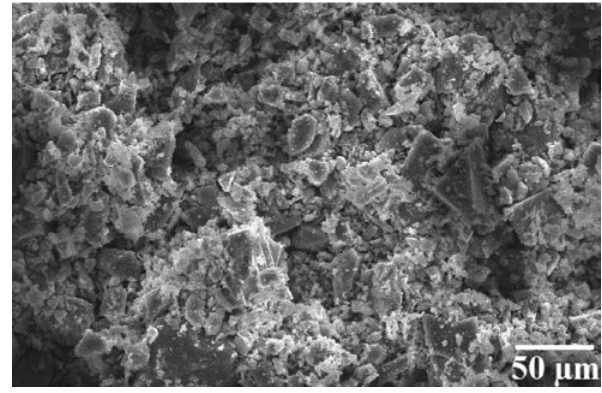
N particles. 3 4